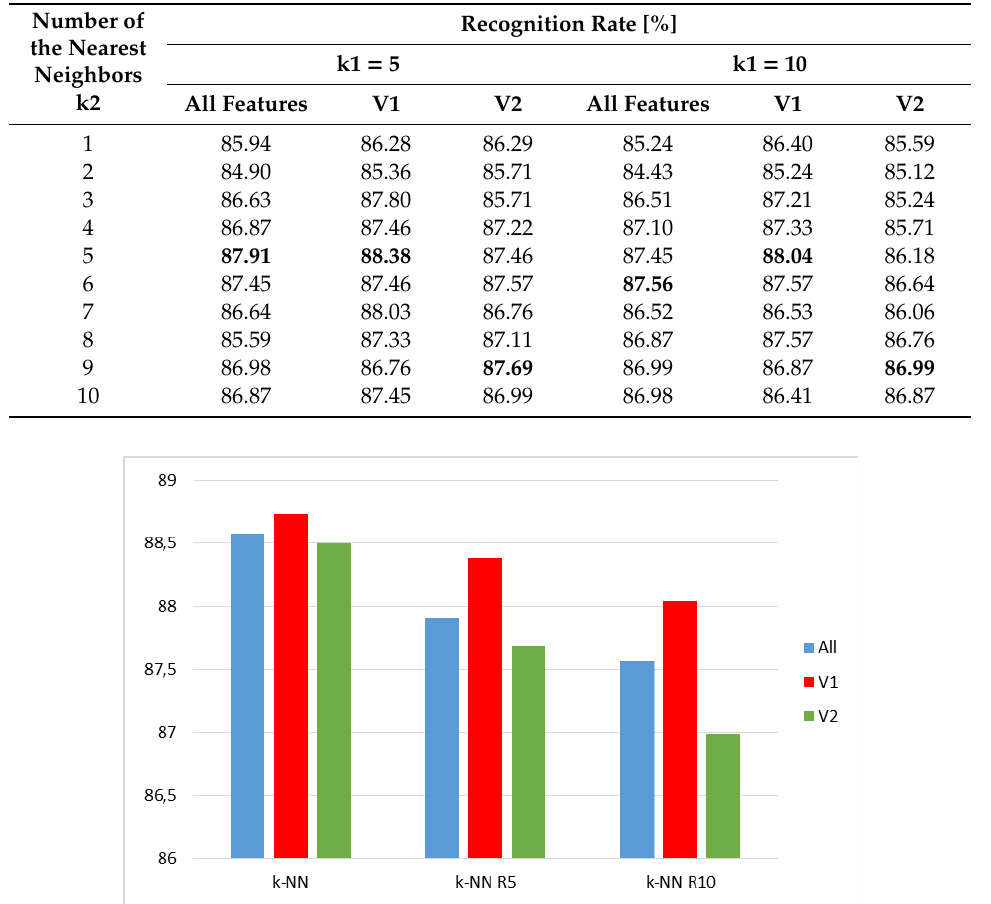
Table 10 . Recognition rates for the UTD-MHAD and k-NN using representatives (eight-fold cross-validation LOSO).